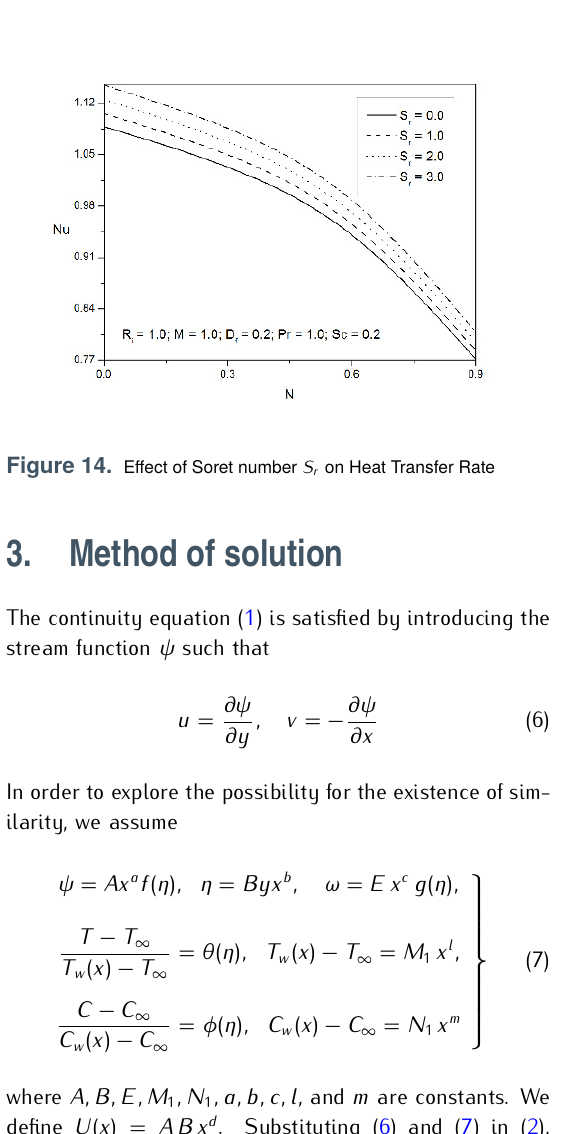
Figure 15. Effect of Soret number S r on Mass Transfer Rate